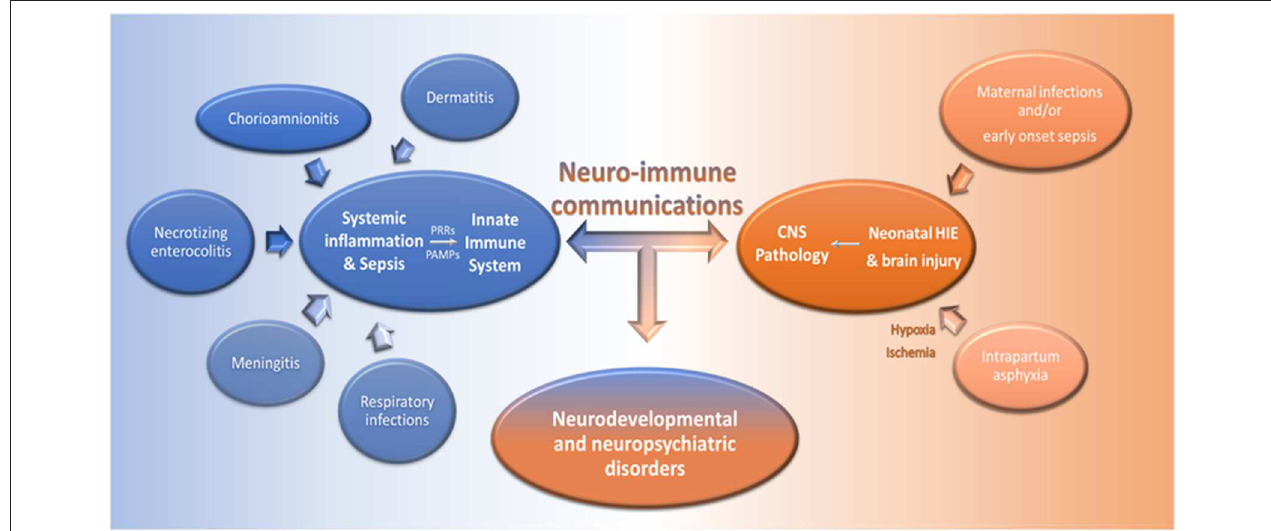
FIGURE 2 | Dysregulated neuro-immune communication underlies the pathology of infections and CNS disorders in neonates. Infections, such as chorioamnionitis, dermatitis, meningitis, necrotizing enterocolitis, and respiratory infections, can lead to systemic inflammation and severe sepsis in newborns. Pathogen associated molecular patterns (PAMPs), generated during infections, are recognized via PRRs by innate immune cells and this induces cell activation and the production of pro-inflammatory mediators in the periphery and the CNS. On the other hand, maternal infections during pregnancy and/or EOS, and intrapartum asphyxia can induce brain injury and HIE, respectively, and further activate innate immune responses. Dysregulated neuro-immune communications underlie the pathogenesis of systemic infections and brain damage in neonates and may lead to neurodevelopmental and neuropsychiatric